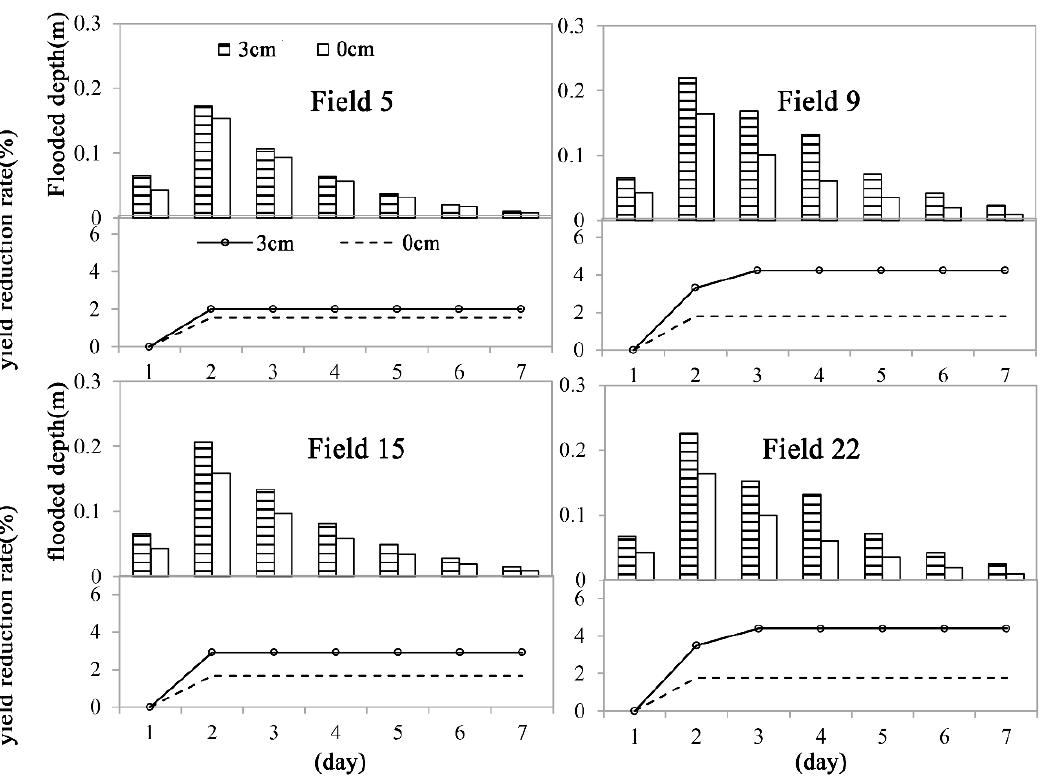
Figure 9. Variation of waterlogging depth and yield reduction rate of paddy fields with different initial storage depths under a 50-year rainfall of the current scenario.